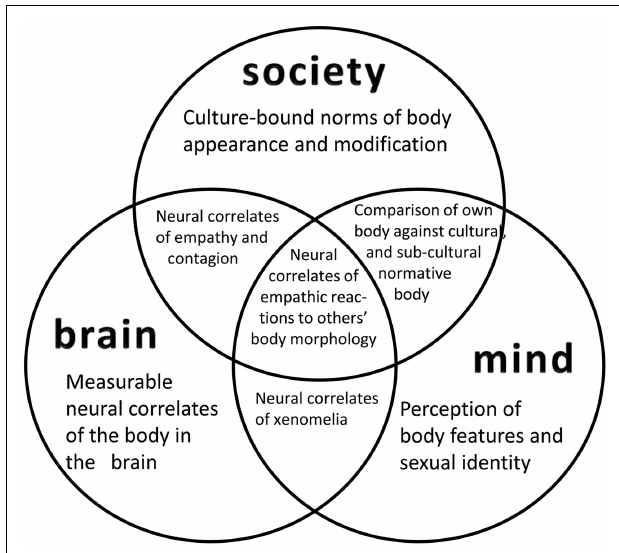
FIGURE 1 |A view of xenomelia research that integrates three approaches. While the crosstalk between neurological (“brain-based”) and psychological (“mind-based”) approaches is commonplace, anthropological, and social studies of bodily appearance and its modifications have been neglected in neuroscience accounts. A social neuroscience view of xenomelia respects the interactions between an individual’s perception of the own body in relation to others’ bodies and as influenced by normative standards. It will also explore the neural correlates of these interactions and investigate, for instance, the constraints of empathy by social norms, or the impact of a person’s preconceptions of a “handicapped body” on brain function and